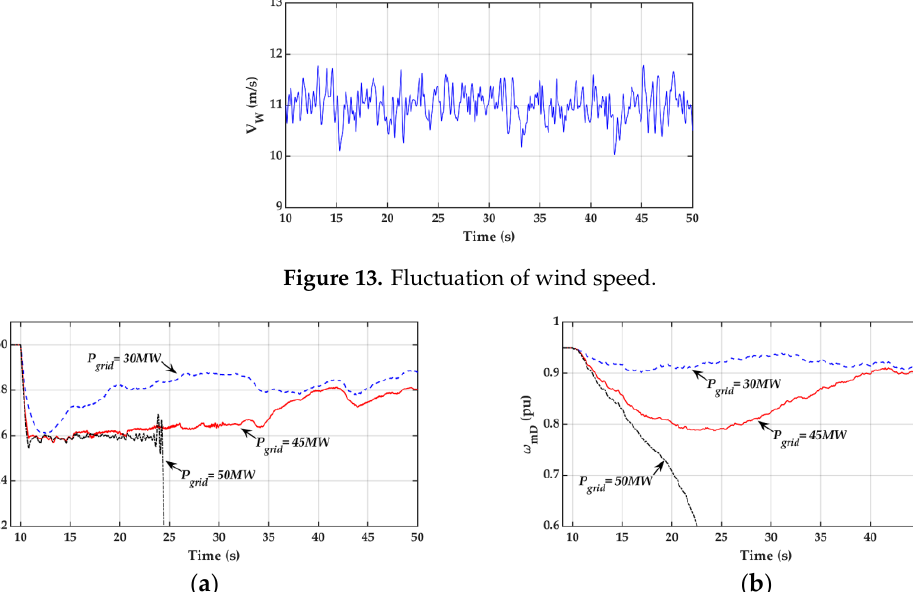
( d ) Figure 12. Comparison of dynamic response curves from the Type I and Type II controllers under change of wind speed ( P grid = 45 MW). ( a ) Frequency, ( b ) DFIG speed, ( c ) PSO proportional gain, ( d ) PSO integral gain. Since the gains of the Type I controller had been selected based on a fixed wind speed of V w = 11 m/s, the system frequency nadir failed to meet the requirement of 59.6Hz when the system was subject to a wind speed change, as evidenced by the frequency response curve in Figure 12a. However, the Type II controller can still maintain a satisfactory frequency response by adjusting the controller gains in real-time when the system is subject to a wind speed change, as shown in Figure 12c,d. 5.2.3. Dynamic Response Curves under Uncertainties in System Parameters and Fluctuation of